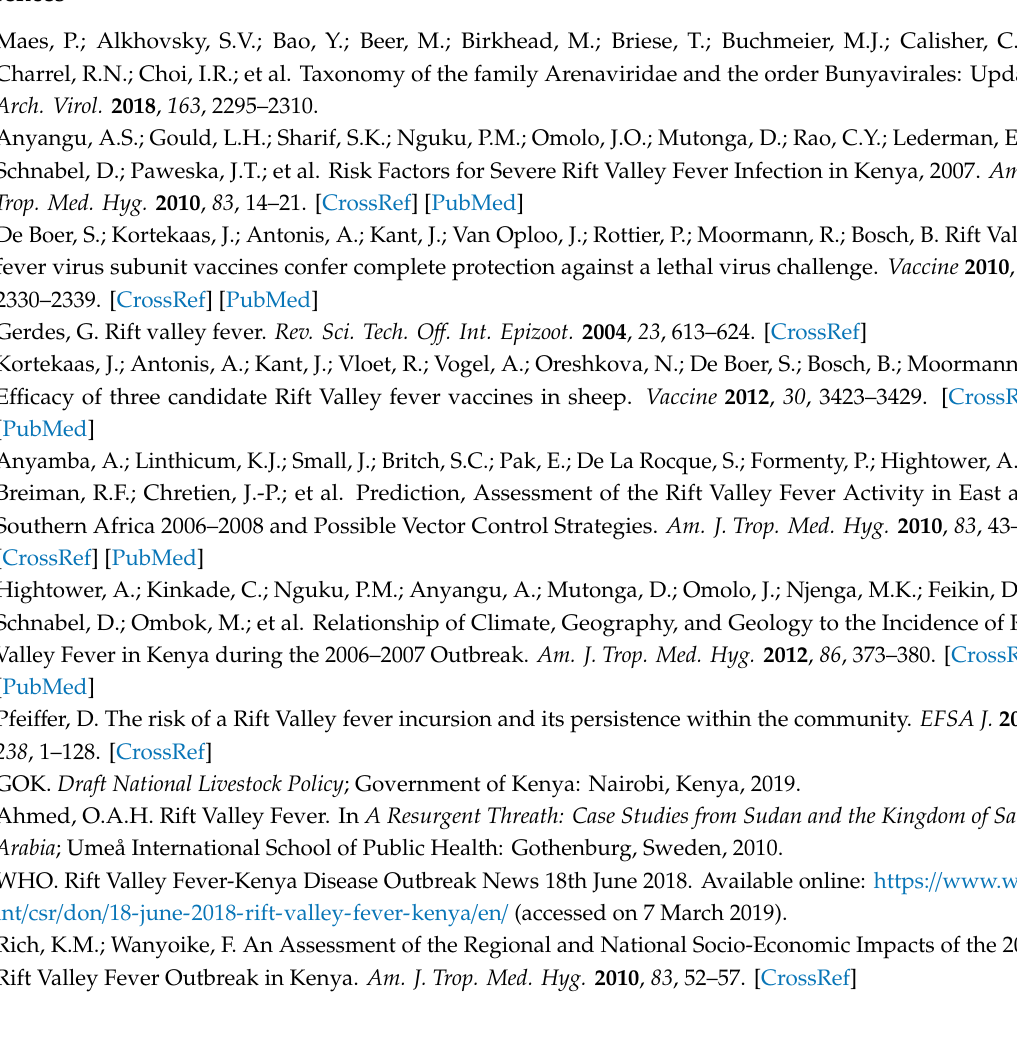
Table S1: Murang’a pairwise ranking data, Table S2: Kwale pairwise ranking data, Table S3: Ibanda pairwise ranking data, Table S4: Arua pairwise ranking